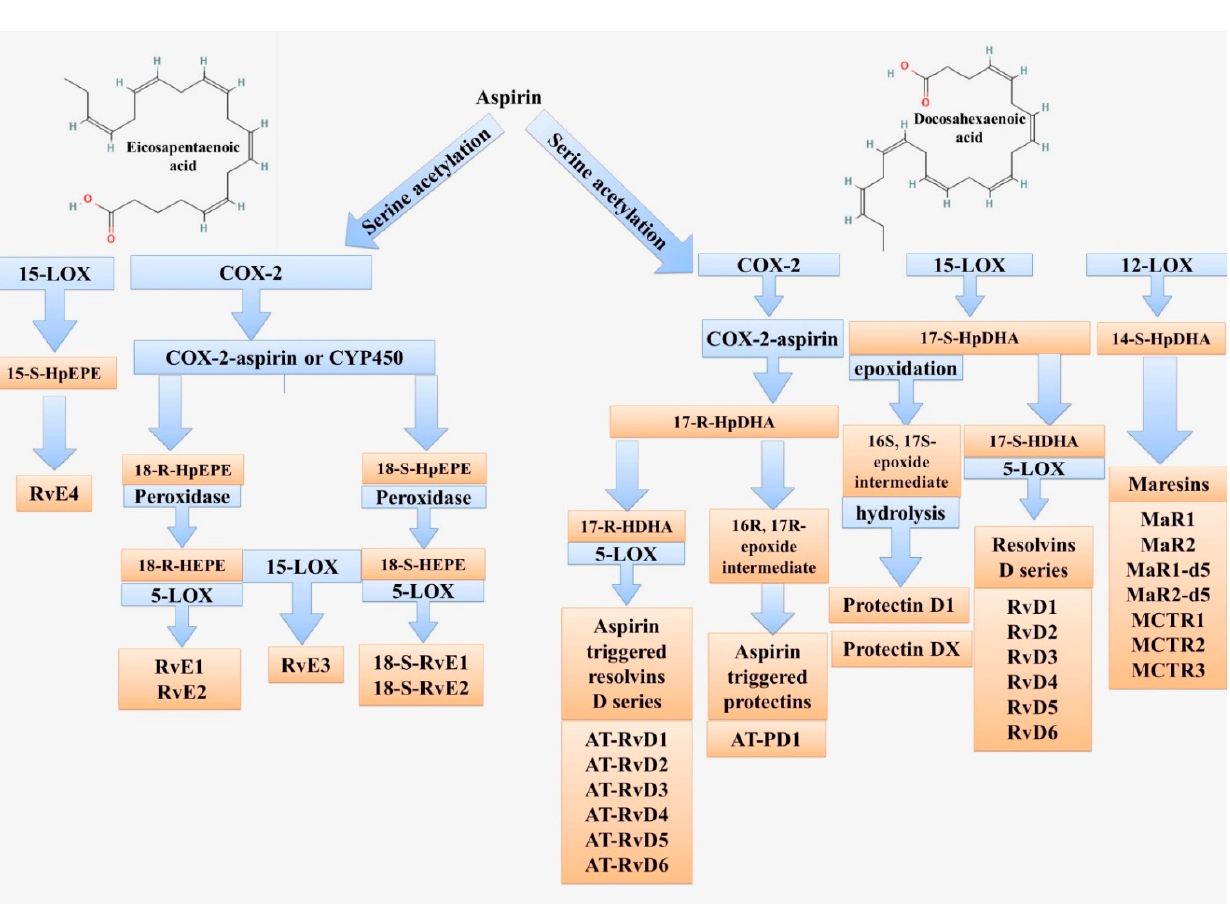
Figure 4. Scheme of lipid mediator biosynthesis from eicosapentaenoic and docosahexaenoic acids. These fatty acids are used to form resolvins (Rvs), maresins (MaRs), and protectins (PDs). The key enzymes are 5-LOX, 12-LOX, 15-LOX, and COX-2.